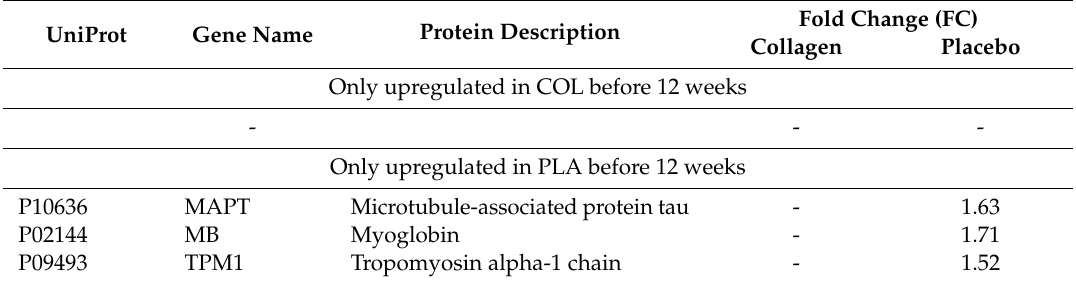
Table 3. Upregulated proteins in the collagen (COL) and placebo (PLA) group showing baseline differences before the intervention.